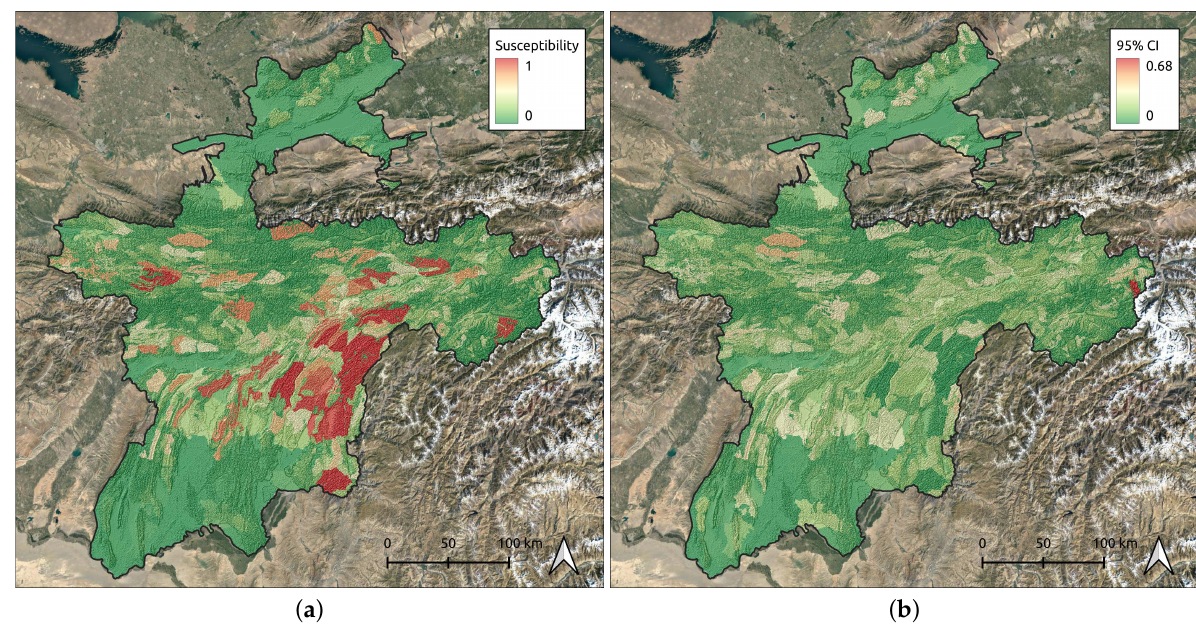
Figure 4. ( a ) Landslide susceptibility map of Tajikistan. ( b ) 95% of Confidence Interval (CI) of the landslide susceptibility map of Tajikistan.